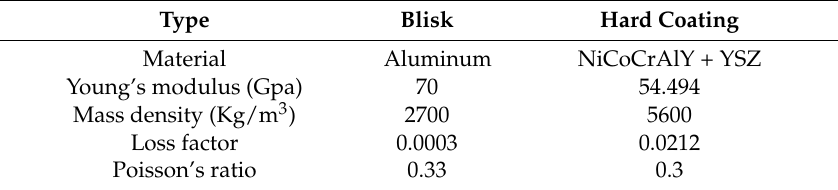
Table 2. Mechanical parameters of the mistuned blisk and hard coating.